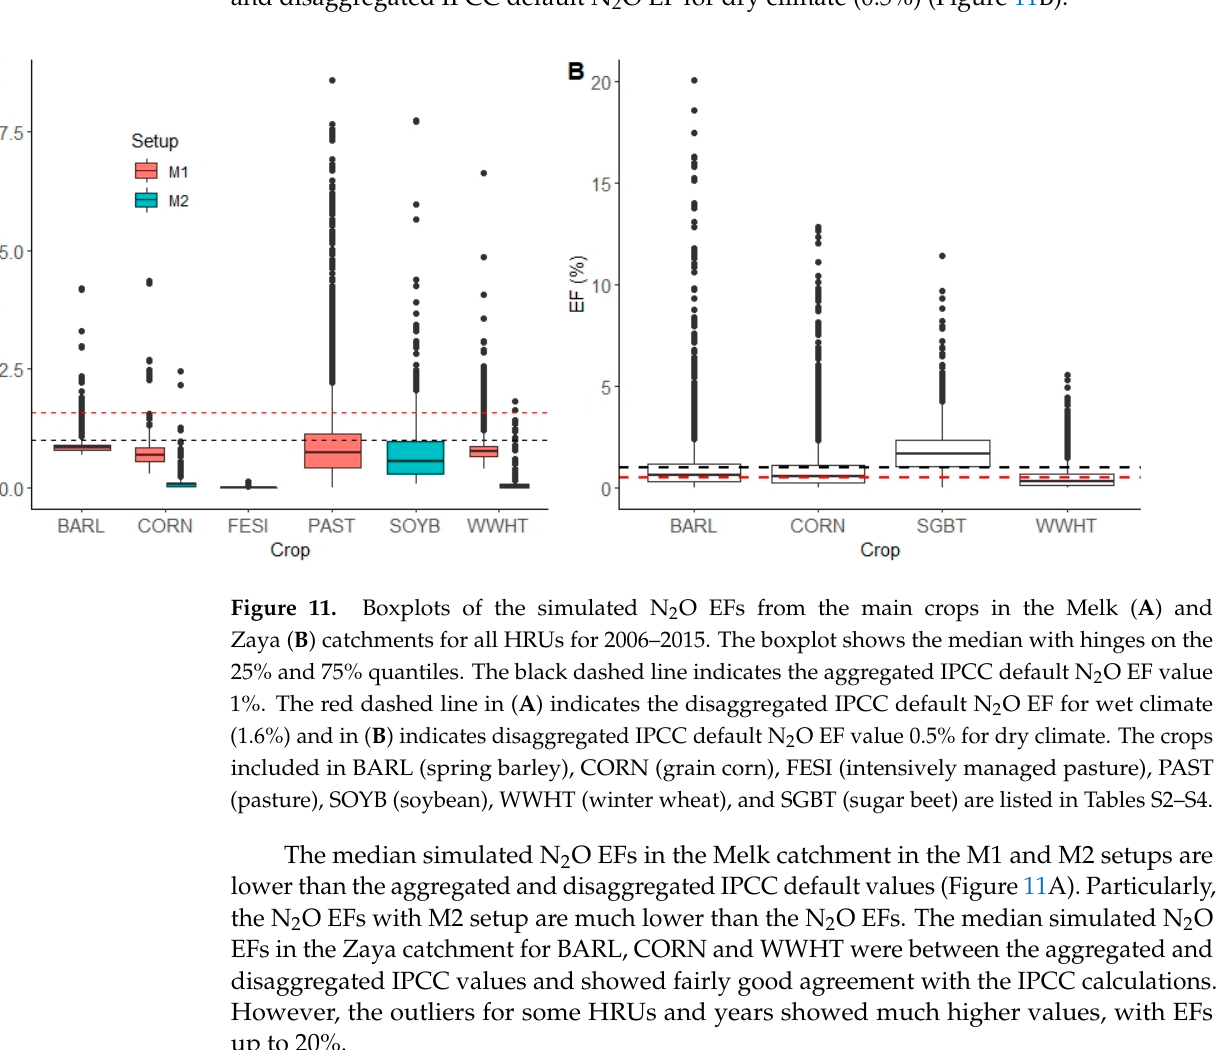
19 of 28 Figure 10. Simulated N 2 O emissions (color lines) from WWHT HRUs in the Zaya catchment for the years 2009 ( A ), 2013 ( B ), 2014 ( C ), and 2015 ( D ). PCP is daily precipitation (mm). Black points indi- cate the dates of N fertilizer application for the setup in the Zaya catchment. 3.6. Comparing Simulated N 2 O Emissions with DNDC Simulations For the M1 setup in the Melk catchment, the same type of N fertilizer, namely, NH 4 NO 3 , was also applied in the DNDC model for MF3 in Kasper et al. [36] (Table 3). The SWAT simulated daily N 2 O from grain corn, winter wheat, and spring barley were higher by 4.73, 3.54, and 5.5 N g ha − 1 , respectively, compared with the DNDC simulated N 2 O in MF3 (Figure 8). For the M2 setup, the applied N fertilizer for grain corn and winter wheat were higher by 10.3 and 18.8 kg ha − 1 , respectively, than the N fertilizer application in MF3 (Table 3). However, the median values of simulated average daily N 2 O emissions from